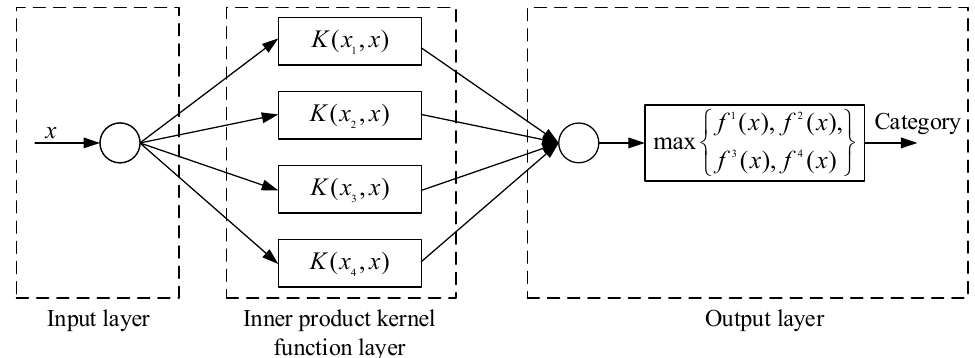
Figure 2. Structure of Support Vector Machine (SVM) classifier.